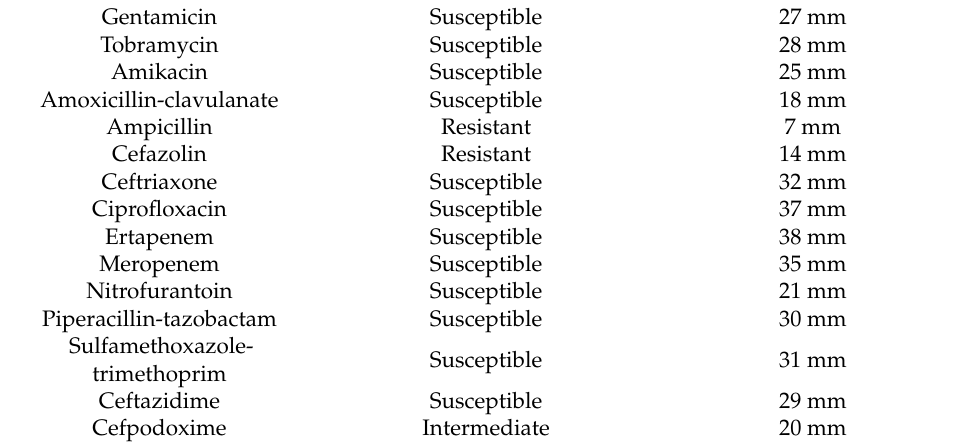
Table 1. Antimicrobial susceptibility of Patient A’s Y. frederiksenii isolate in stool culture (with Kirby–Bauer zone of inhibition diameter in millimeters)